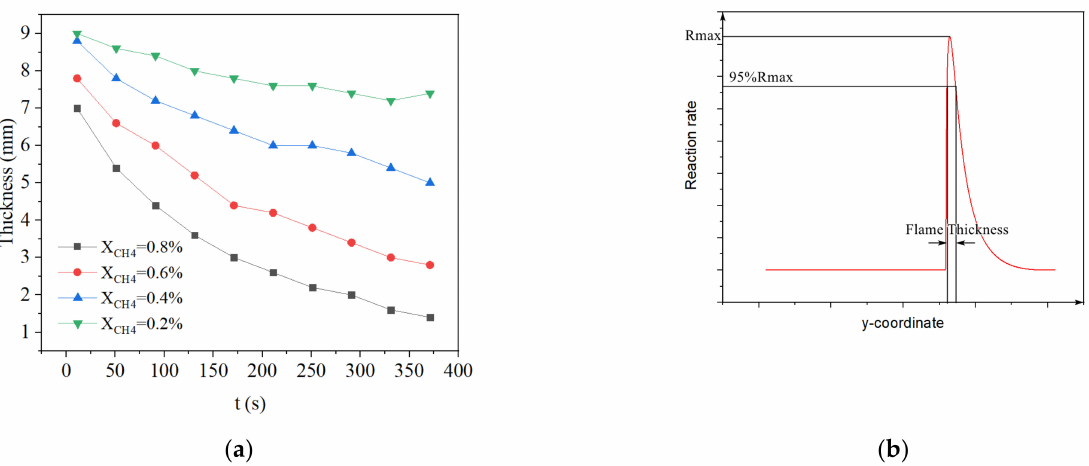
Figure 12. Variation of flame thickness with time at different concentrations with the inlet flow rate of 700 m 3 /h. ( a ) The thickness of the flame; ( b ) Flame thickness calculation method. Table 3. Parameters in this section. X CH